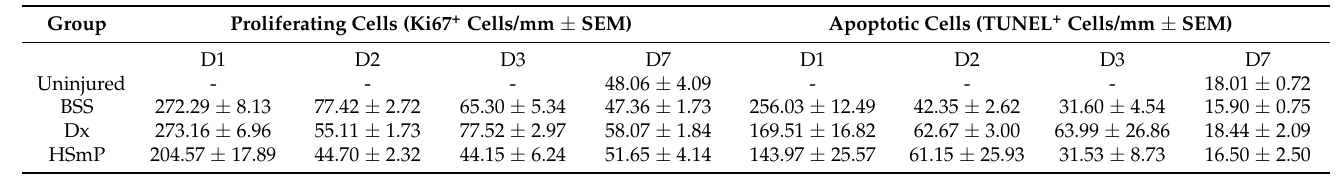
Figure 2. Proliferative cells at day 1 and day 3 after injury. In red, cells expressing Ki67 as a marker of proliferation. Uninjured corneas ( a , b ) showed a low number of proliferative cells restricted to the basal layer of the epithelium. HSmP-treated corneas ( g ) showed a lower number of proliferative cells compared to vehicle ( e ) and BSS ( c ) one day after injury. Numbers of Ki67+ cells were greatly reduced at 72 h in all groups ( d , f , h ). HSmP presented a lower number of Ki67+ cells. Dashed lines mark the border of the initial injury in the 1 D series of images (scale bars: 50 µm). Table 2. Values of cell density attending to proliferation and apoptosis during the corneal wound